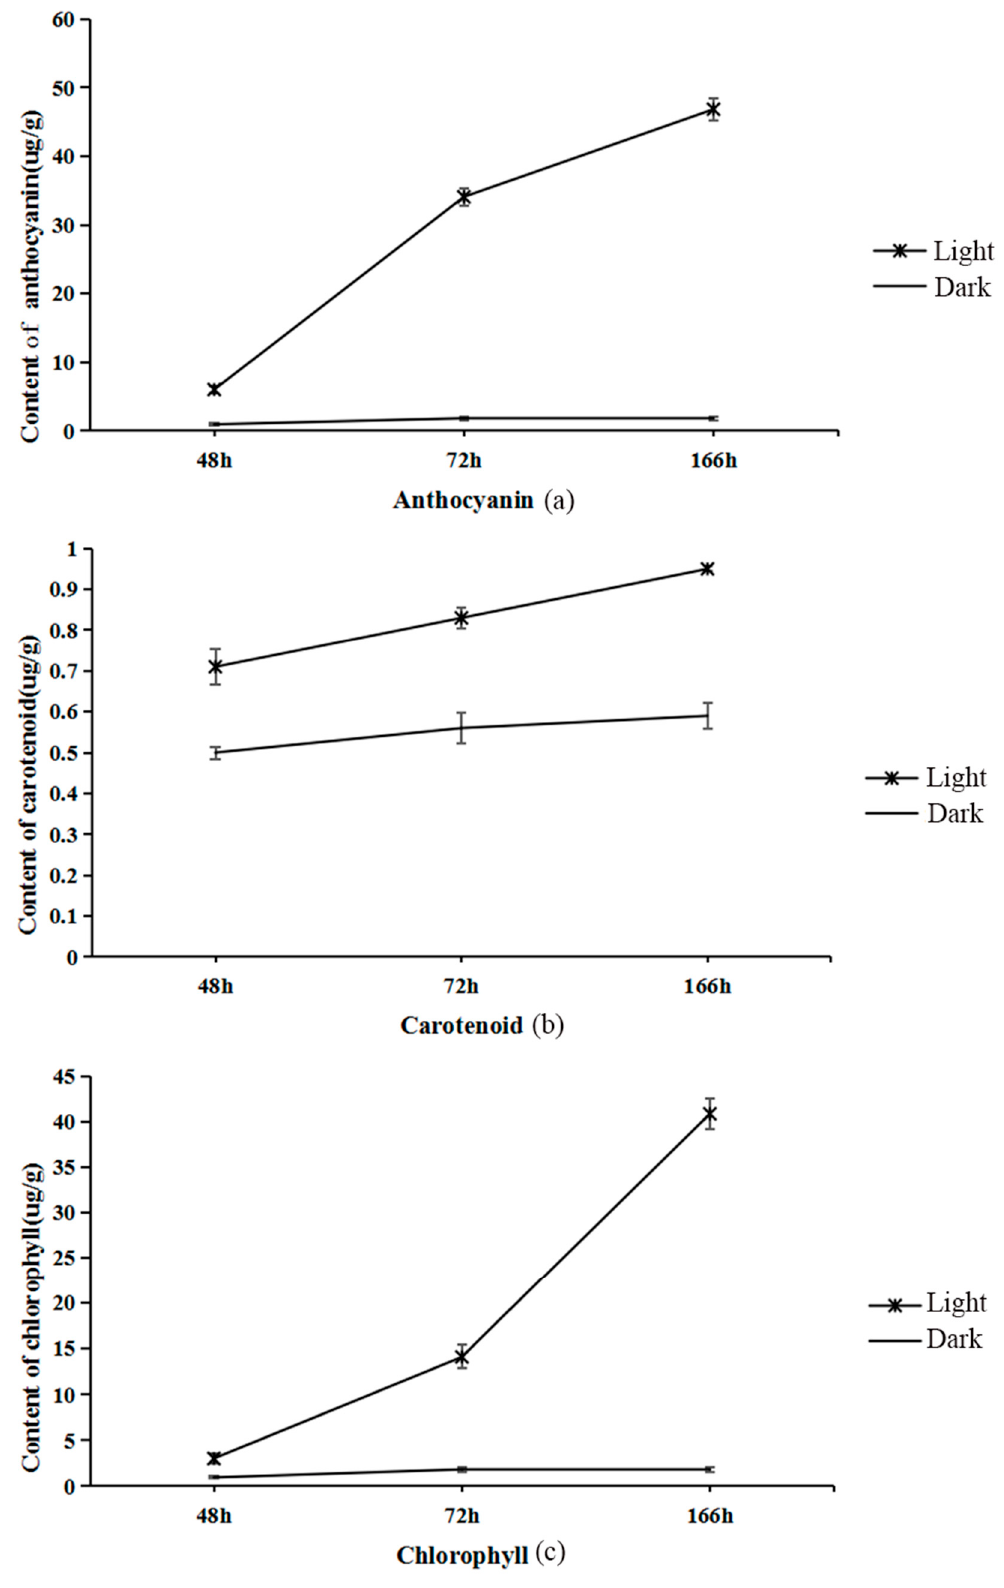
Figure 2. The content of anthocyanins, carotenoids, and chlorophyll in the peel of capsicum. The x-axes are the times of different treatments, and the y-axes represent the content of various substances, anthocyanins ( a ), carotenoids ( b ), and chlorophyll ( c ). Unit µg/g freeze-dried). The pictures show the average value of three biological repetitions. The error bars indicate the standard deviation.